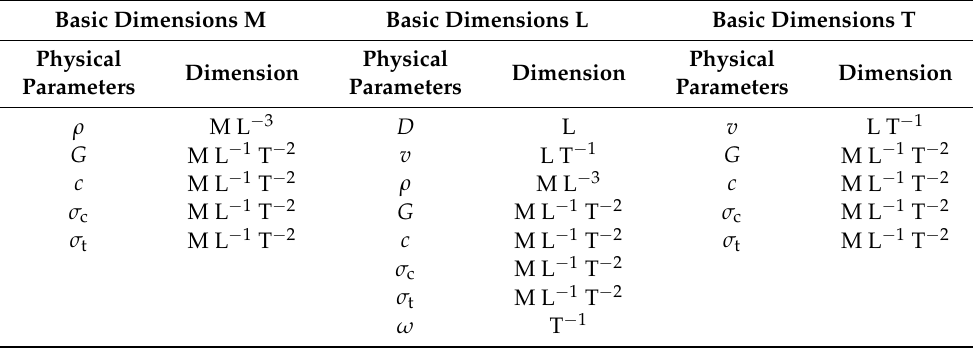
Table 2. Grouping of the influencing parameters based on basic dimensions. Basic Dimensions M Basic Dimensions L Basic Dimensions T Physical Physical Physical Dimension Dimension Parameters Parameters